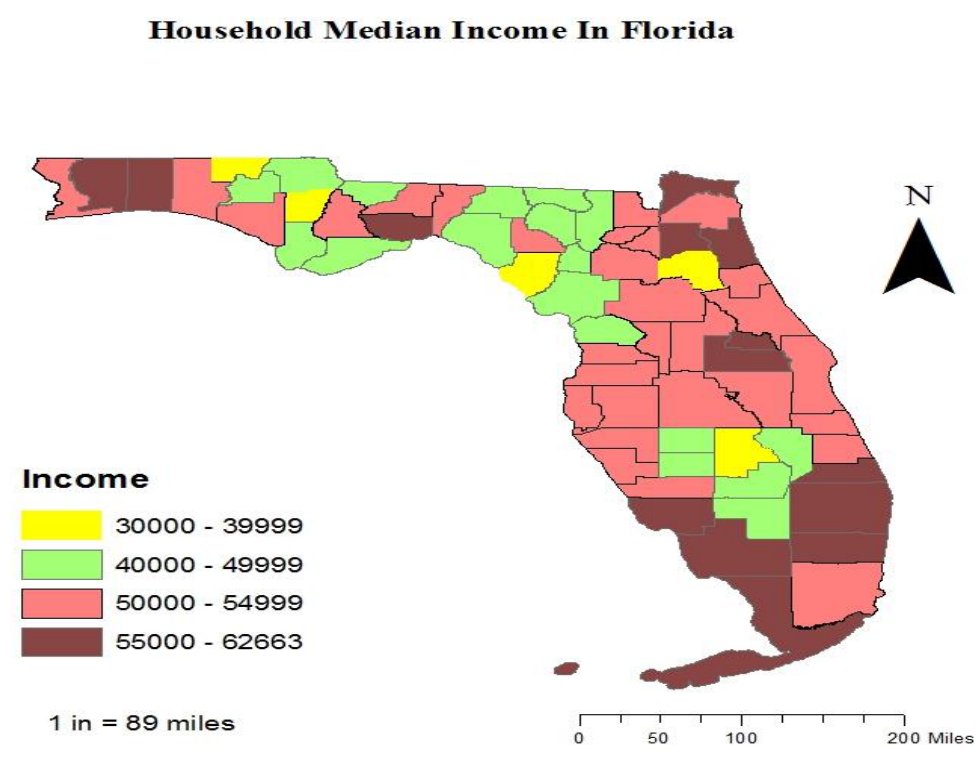
Figure 3. Median income map per county in Florida. Table 2. Parameter estimates for not receiving influenza vaccine in the past